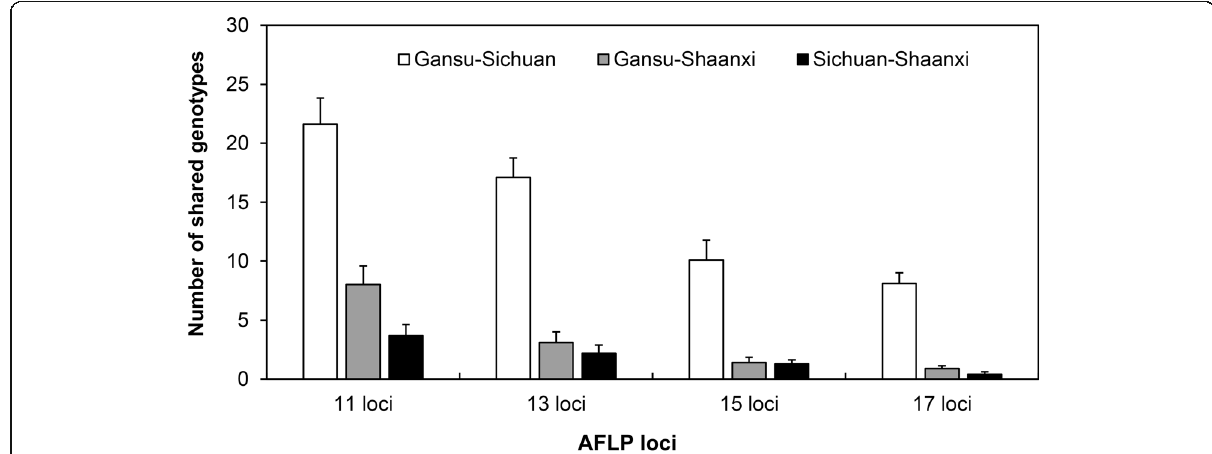
Fig. 1 Number of shared genotypes between paired province populations of Puccinia striiformis f. sp. tritici . Shared genotypes between combinations of Gansu-Sichuan, Gansu-Shaanxi, and Sichuan-Shaanxi were calculated based on the 11, 13, 15, and 17 loci randomly selected from the total of 98 AFLP loci using GenClone version 2.0. Bars represent standard errors from ten independent